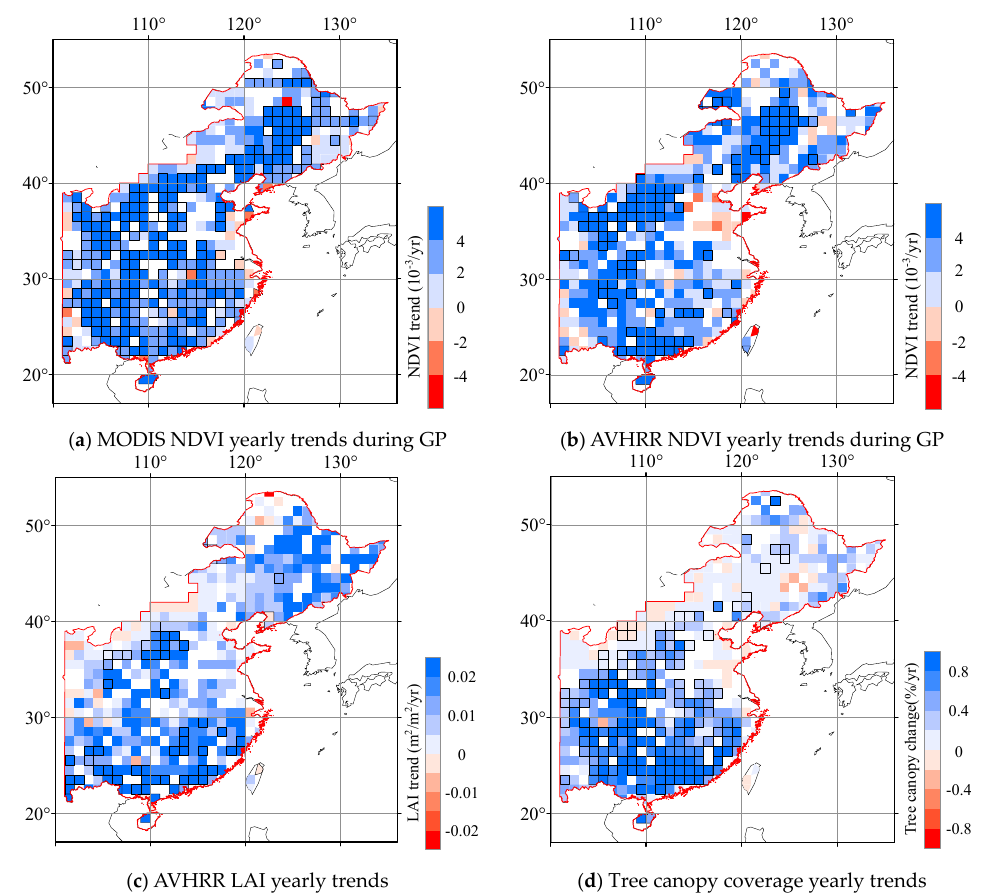
Figure 4. Growing period greening trends from 2003 to 2016 in ( a ) Moderate-Resolution Imaging Spectroradiometer (MODIS) normalized difference vegetation index (NDVI) and ( b ) AVHRR NDVI. Annual trends for the same years in ( c ) Advanced Very-High-Resolution Radiometer (AVHRR) leaf area index (LAI) and ( d ) tree canopy coverage. Increasing trends are in blue with decreasing trends in red, and grid cells with black outlines indicate trend significance using the Mann–Kendal test ( p < 0.05). All vegetation indices show significant greening in Eastern China, outlined in red.